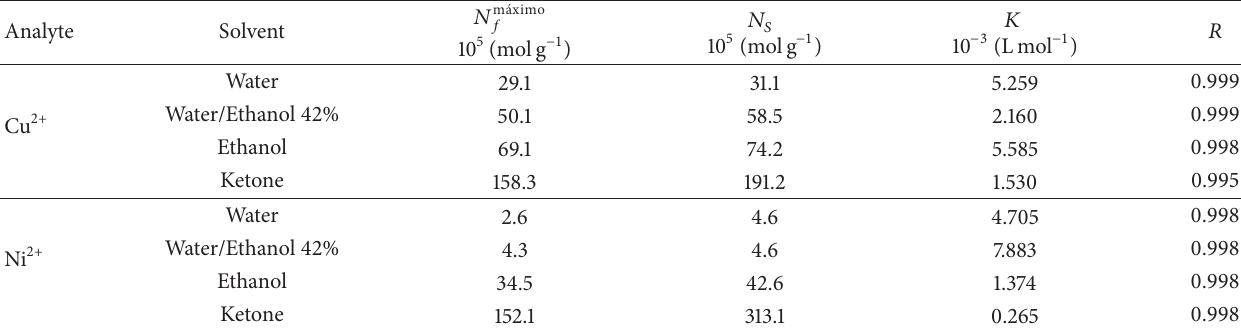
Table 3: Calculated parameters for the sorption of Cu 2+ and Ni 2+ onto SGAPC and values of 𝑁 𝑓 and correlation coefficient ( 𝑅 ). Analyte